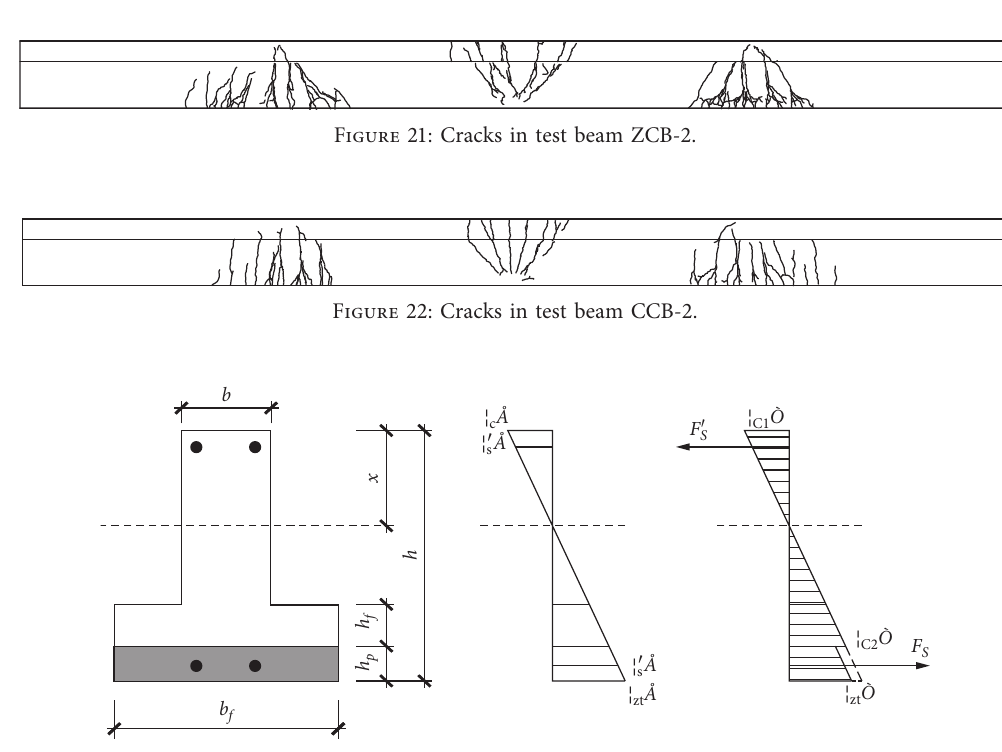
Figure 23: Stress and strain distributions of the single-span composite T-shaped